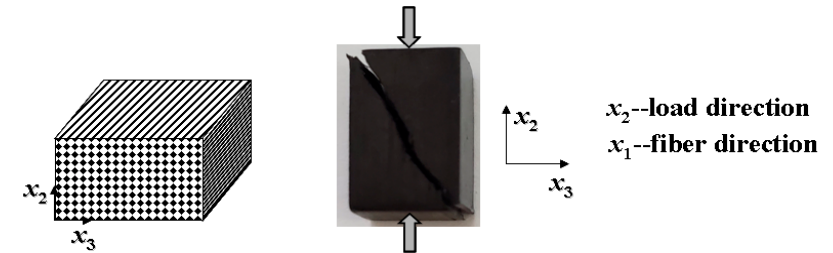
Figure 10. Failure surface of a UD composite under a compression.